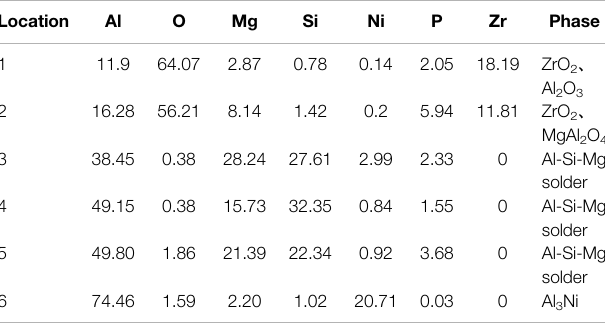
TABLE 3 | EDS scan results of each point in Figure 7 (at%). Location